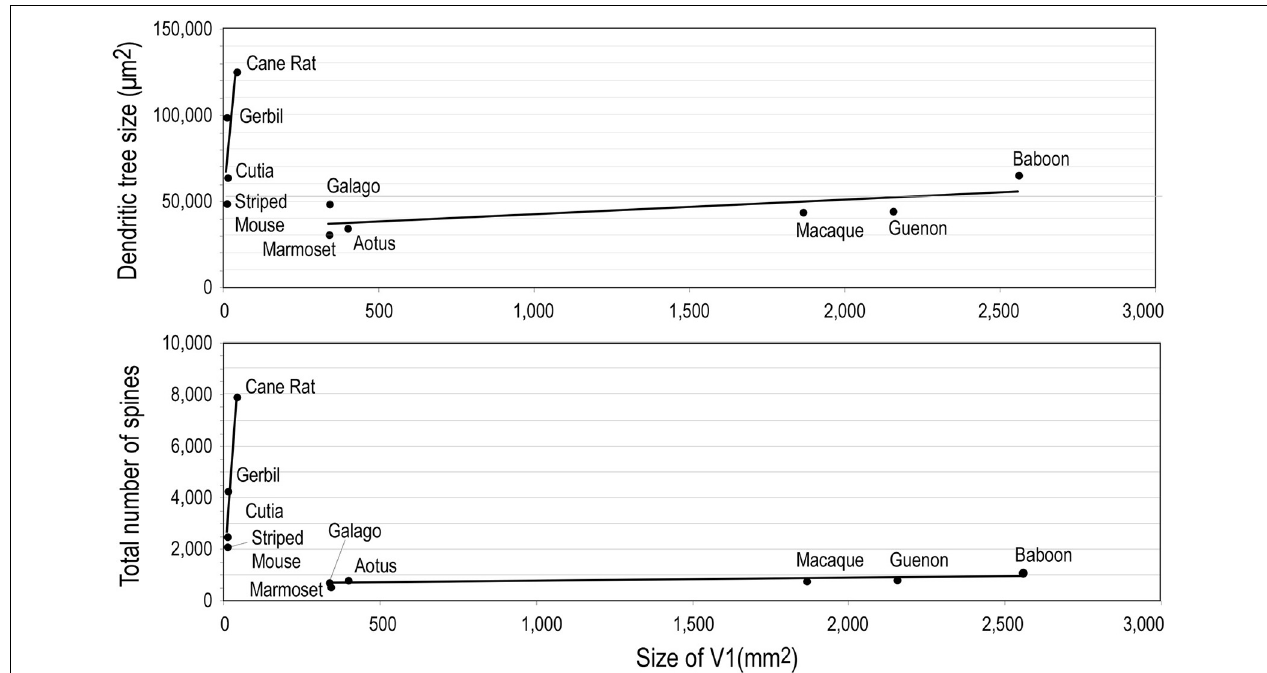
FIGURE 14 | Neurongrowthandcorticalsize. Graphsillustratingphylogentic differencesinthetrendsbetweenpyramidalcellstructureandsizeoftheofthe primary visual area (V1) in rodents and primates. Illustrated are the size of, and numberofdendriticspinesin,the“average”pyramidalcellvs.thesizeV1inthe